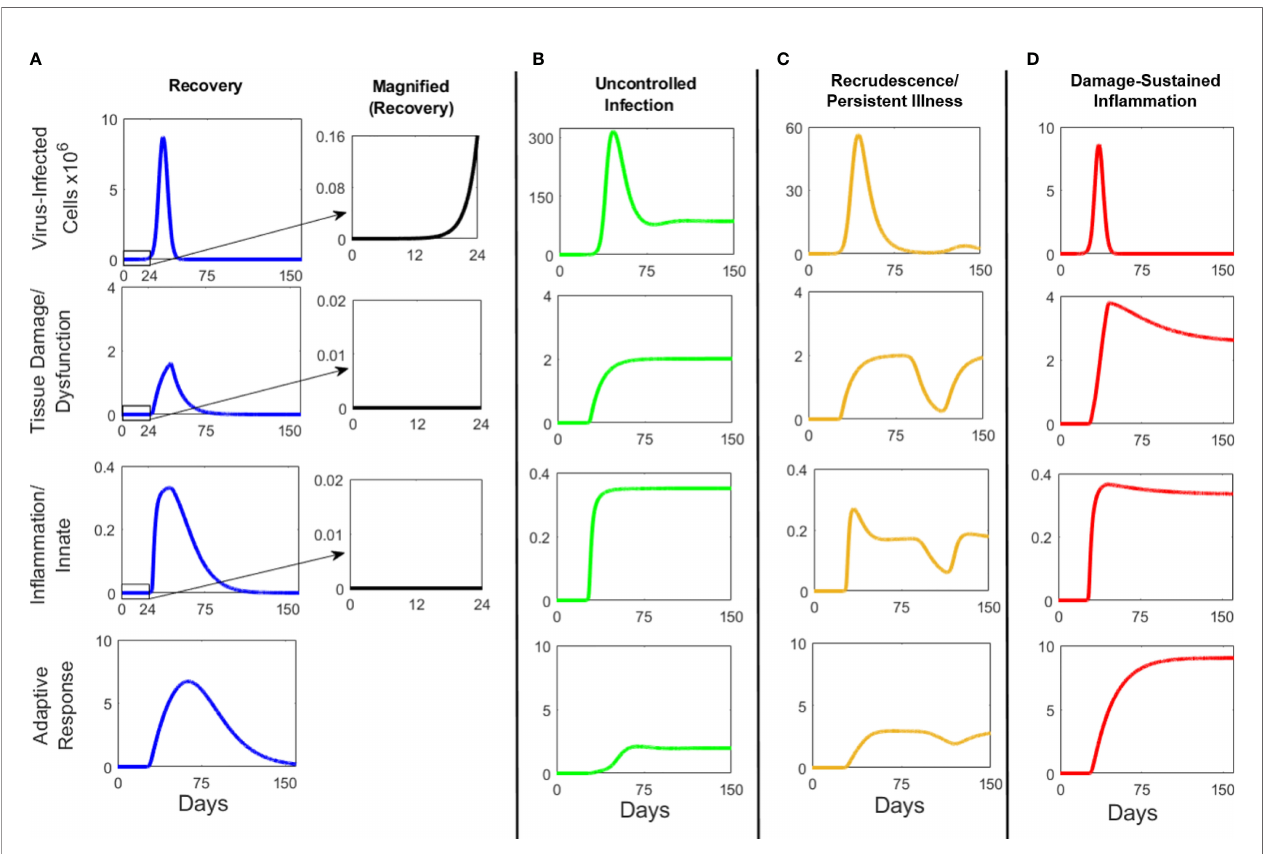
FIGURE 2 | Illustrations of theoretical response dynamics of the SARS-CoV-2 model. Panels (A – D) display uncalibrated simulations of model variables C V , D , I , and A where each column illustrates a response pro fi le of these variables for the indicated archetype. Magni fi ed outsets to the immediate right of Panel A illustrate that a window of time exists during which the virus-infected cell population, C V , is increasing but the host damage/tissue dysfunction ( D ; Panel (A) 2 nd row) and innate/in fl ammatory immune response ( I ; Panel A 3 rd row) is negligible. Each simulation set (column) is initiated with the equivalent of one virus-infected cell at time zero ( C V =1; Panels (A – D) top row) into a naïve simulated individual, meaning the speci fi c immunity (A; Panels (A – D) (Panel B ), bottom row) to C V is absent at time zero. Together, each panel (column) of time courses of the model variables represent a potential COVID19 archetype. Initial exposure amounts along with speci fi c, early dynamics related to viral infectivity of cells are largely intractable aspects of disease processes outside of a controlled experiment. Thus, we assume that exposures leading to a productive viral infection will have established, at some time, at least one infected cell, from which other cells will become infected. Assuming larger initial levels of the virus-infected cell population at time zero essentially shift the curves to the left, allowing for a more rapid expansion of the virus-infected cells as well as the ensuing